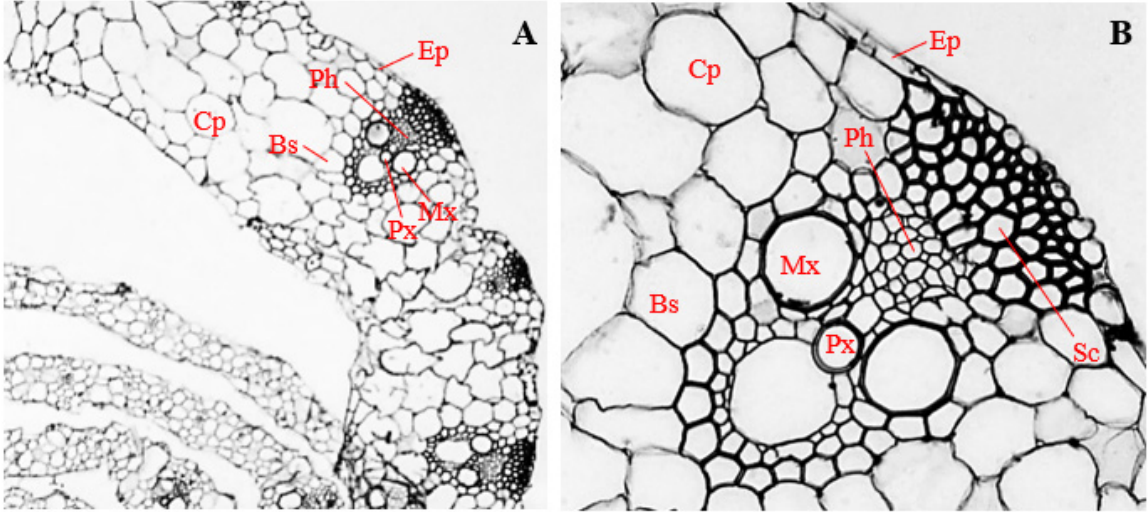
Figure 8. Transverse section of corn stem infected with endophytic Penicillium citrinum . ( A ) Magni- fication 200×; ( B ) magnification 400×. Ep, epidermis; Cp, cortical parenchyma; Sc, sclerenchyma; Ph, phloem; Mx, metaxylem; Px, protoxylem; and Bs, bundle sheath.